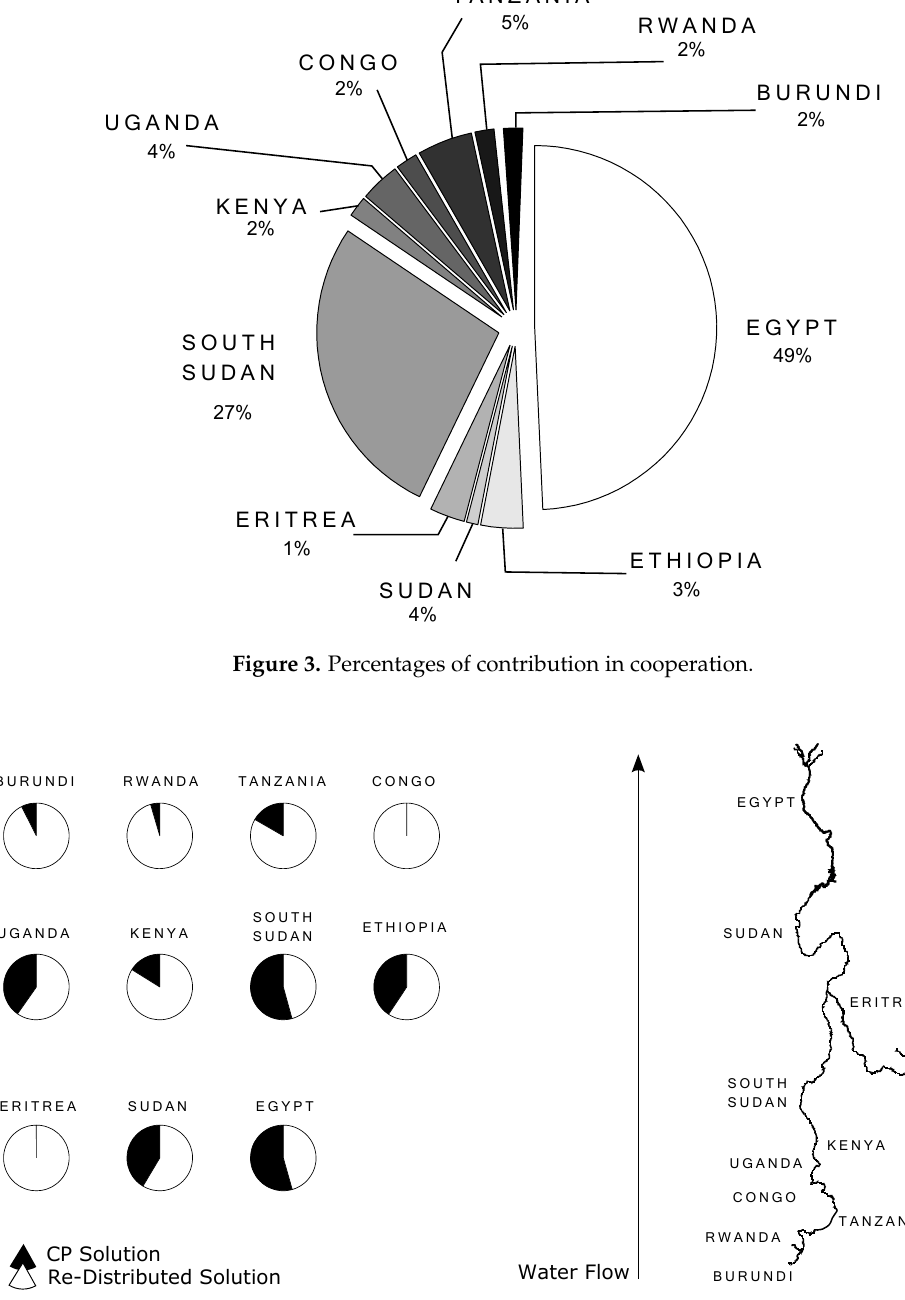
Figure 4. Revenue allocation results in central planner (CP) solution and reallocation